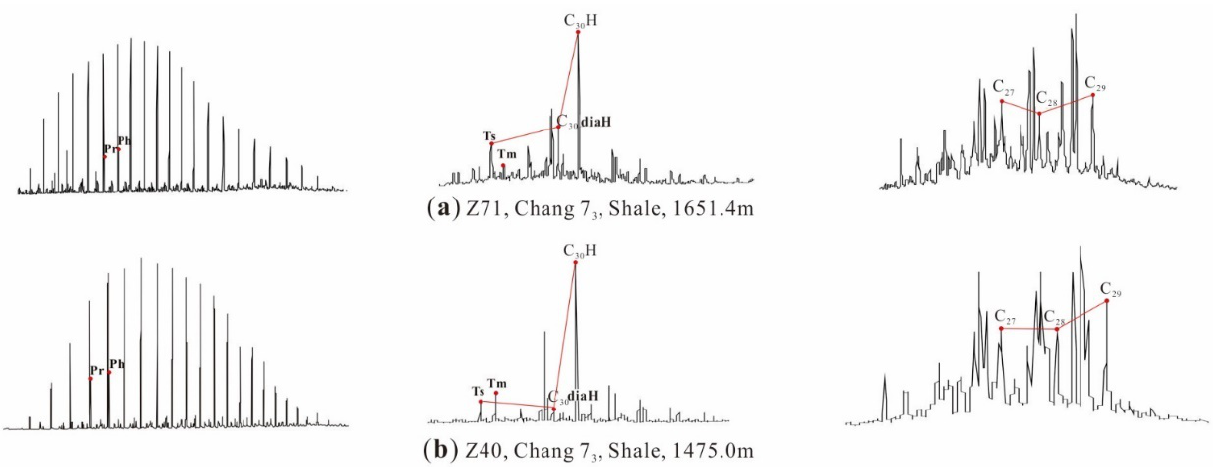
Figure 2. Mass spectra of m/z191 and m/z217 and saturated hydrocarbon chromatography from Chang 7 3 shale of typical well: ( a ) the sample at 1651.4 m from Well Z71; ( b ) the sample at 1475.0 m from Well Z40). Table 2. The geochemical indexes extracting from well samples of Chang 7 3 shale.